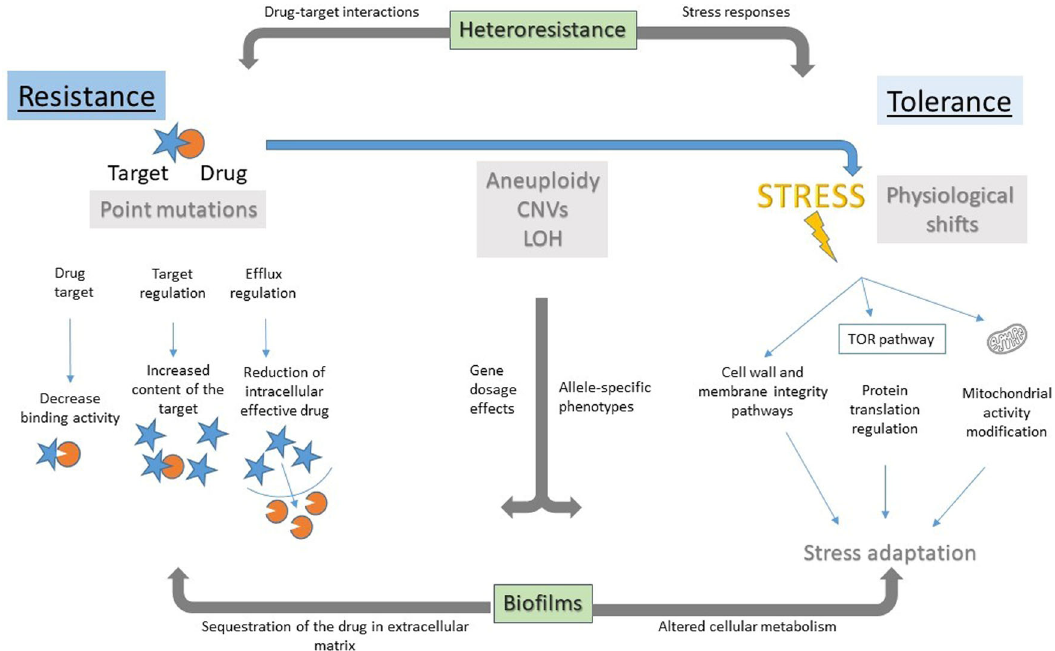
Fig. 1 | Overview of antifungal drug responses. Antifungal drug resistance (left side) is detected as elevated MIC due to direct effects on drug (orange circle) or drug target (blue star), via reduced binding af fi nity of the target for the drug, increased levels of the target that dilute the drug effect, or by reducing the intracellular drug concentration via drug ef fl ux or blocked drug uptake. Anti- fungal drug tolerance (right side) is a physiological response to drug stress involving pathways that buffer the stress, such that some cells are able to grow, albeit slowly, in the presence of drug concentrations that are inhibitory to other cells in the population. This involves physiological shifts in: the cell wall or membrane integrity pathways (including pathways regulated by Hsp90, calci- neurin, and the Crz1 transcription factor, and pathways affecting membrane lipid composition); protein translation machinery including the TOR pathway; and modi fi cations of mitochondrial function. Loss of mitochondrial DNA in